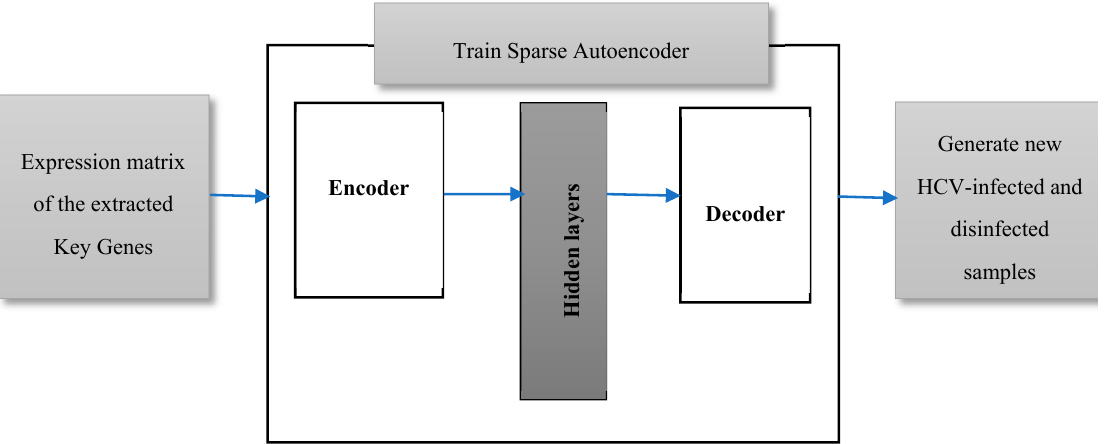
Figure 3. The proposed data augmentation model using a sparse autoencoder to generate additional samples.